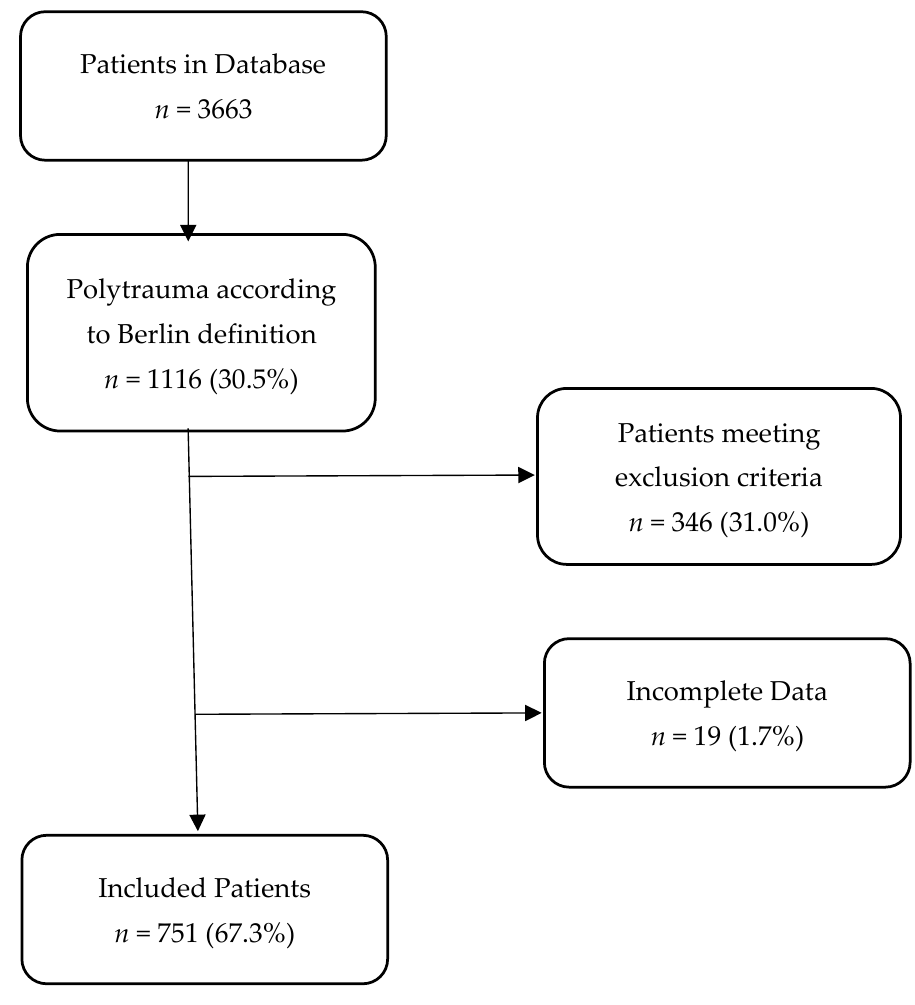
Figure 1. Flowchart of patient selection. The median age of the study population was 39 years (25, 48), with 558 (74.3%) patients being male. The median ISS was 38 (29, 45 (25th, 75th percentile)) and patients had a median GCS of 3 (3, 12) points. The median entry lactate level of all included patients was 3 mmol/l (2, 5), and the median entry arterial pressure (MAP) of all included patients was 87 mmHg (70, 100). Group ESI included 711 patients (94.5%) and Group non-ESI had 40 (5.5%) (Table